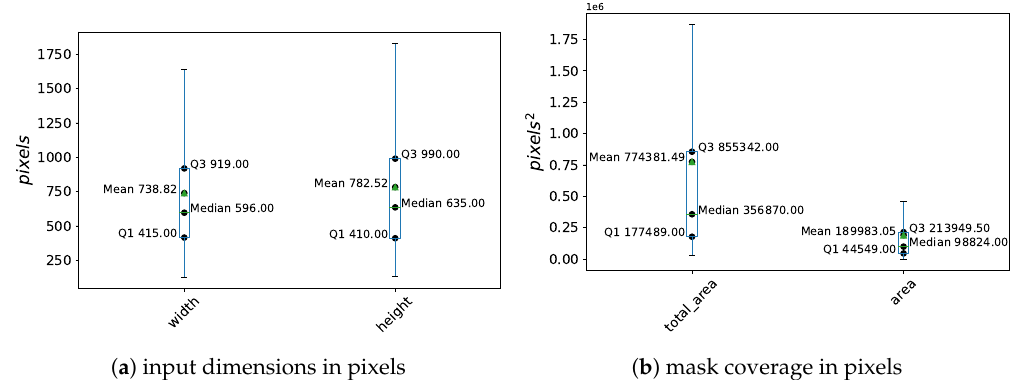
Figure 4. Size and sparsity statistics of the input images. ( a ) depicts width and height distribution of the parking lot satellite images; ( b ) contrasts total area of the images (left) vs. parking block polygons area